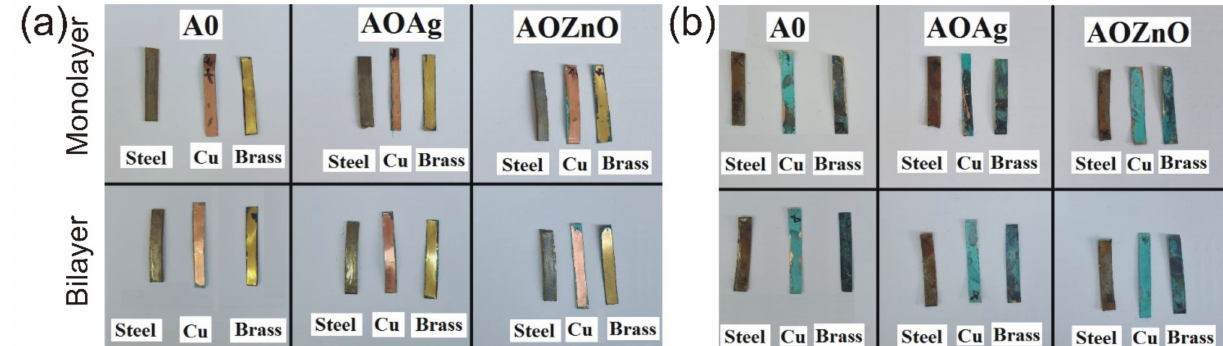
Figure 5. Images of brass, copper and mild steel plates after their exposure to a pollutant (NO 2 ): ( a ) face protected with monolayer (top) and bilayer (bottom) coatings (A0 = the reference film, without nanoparticles; AOAg = film doped with Ag nanoparticles (0.15%); AOZn = film doped with ZnO nanoparticles (0.75%)) and ( b ) the unprotected face of the same